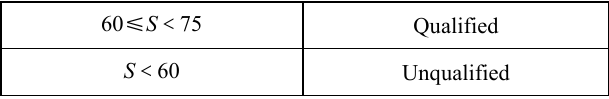
Table 3. Evaluation criteria for quality